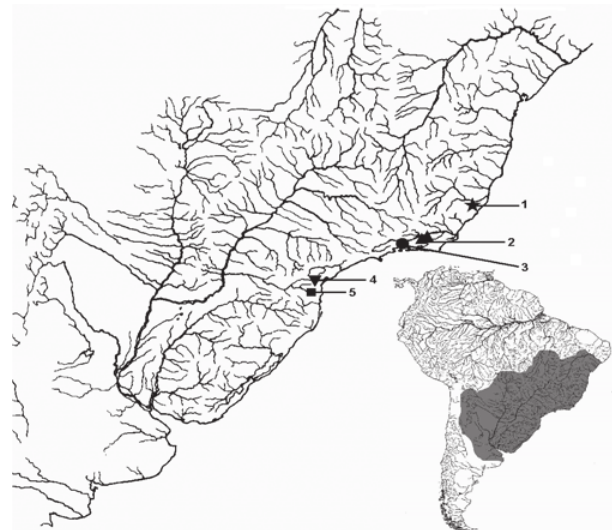
Fig. 18. Collection localities of Phalloceros elachistos (five- pointed star, 1), P. leptokeras (triangle, 2), P. aspilos (circle, 3), P. alessandrae (inverted triangle, 4), and P. megapolos (square, 5). Some symbols represent more than one lot or locality. Numbers represent type localities. The inset is the range of the